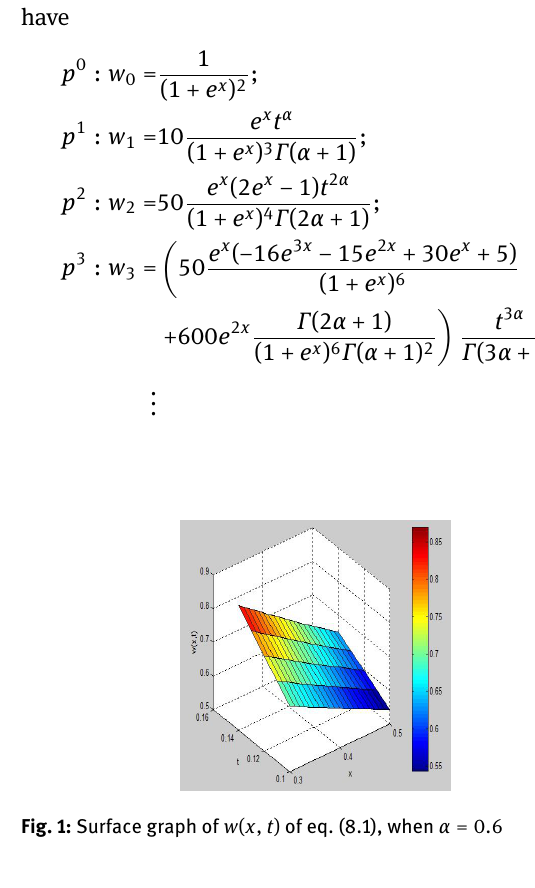
Fig. 1: Surface graph of w ( x , t ) of eq. (8.1), when α = 0.6